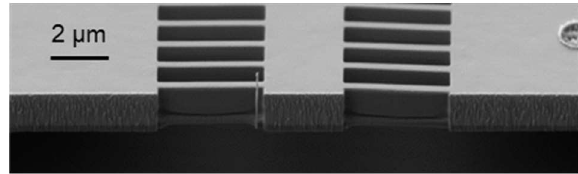
Fig. 3. SEM image of a suspended germanium waveguide designed to operate at a wavelength of 7.7